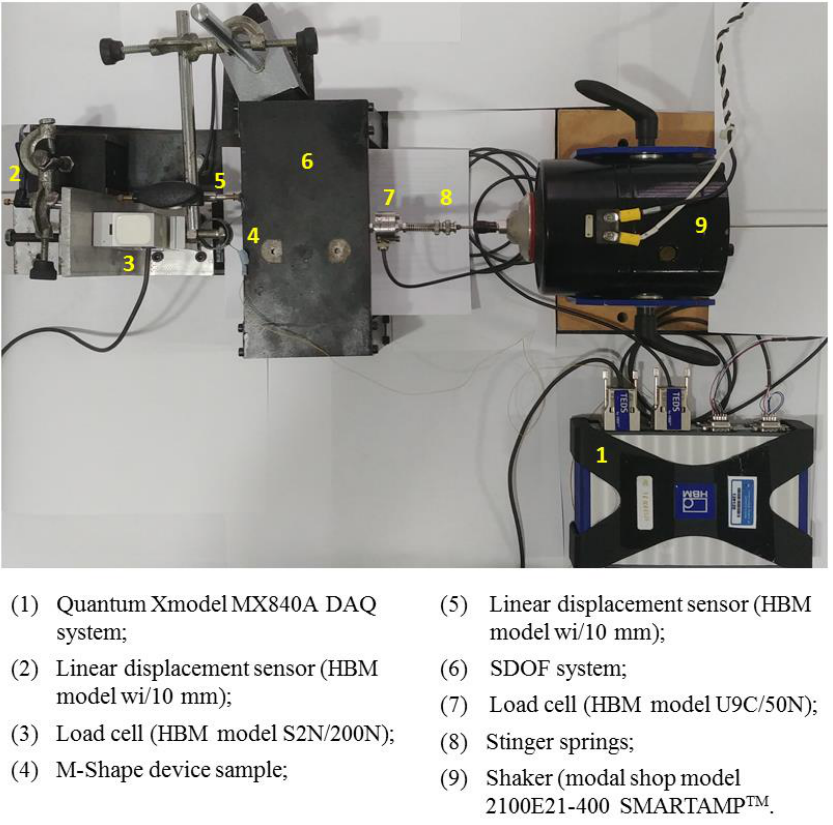
Figure 6. Photograph of the equipment used in the SEMD experiment.